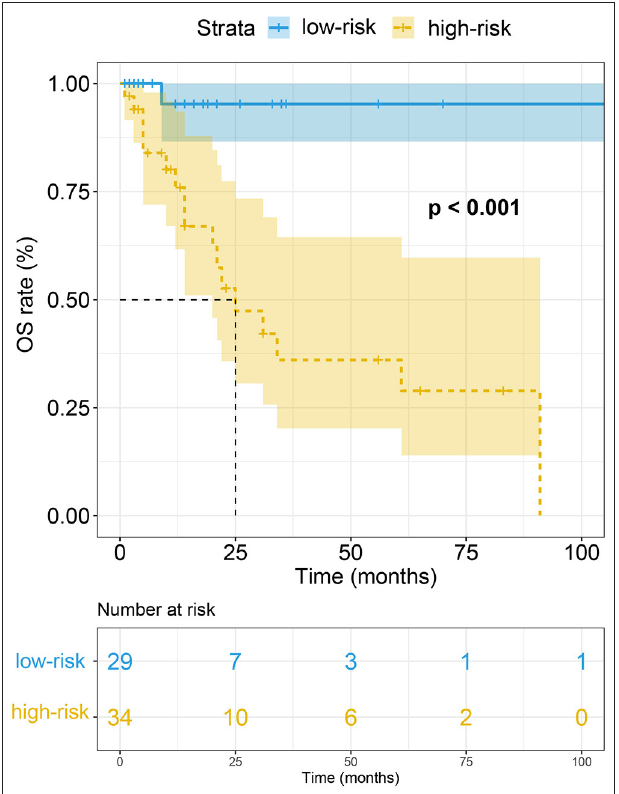
FIGURE 4 | Kaplan-Meier curve of the overall survival rate in high-risk and low-risk